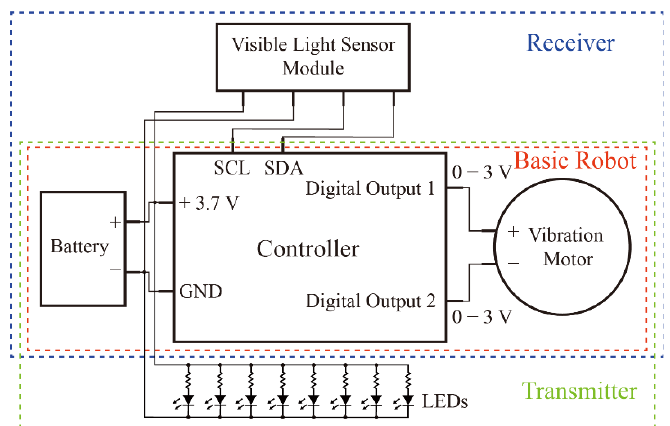
Figure 2. Schematic diagram of the control circuit.